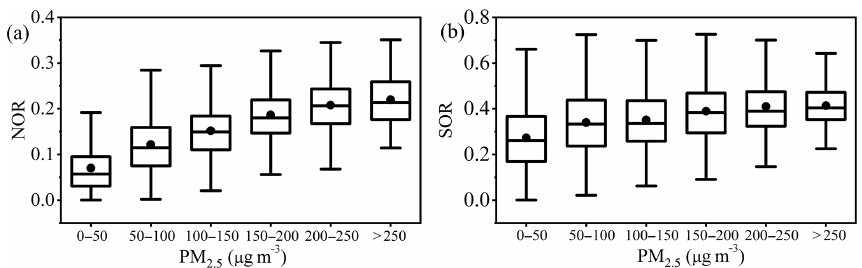
Figure 6. Analysis of atmospheric chemical conversion ability at different PM 2 . 5 concentrations. (a) NOR (nitrogen oxidation ratio). (b) SOR (sulfur oxidation ratio).